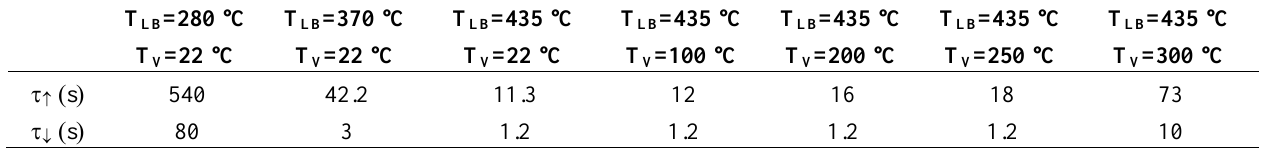
) and response (τ ) time constants at different xenon   ) and vapor gas mixture temperatures (T LB V